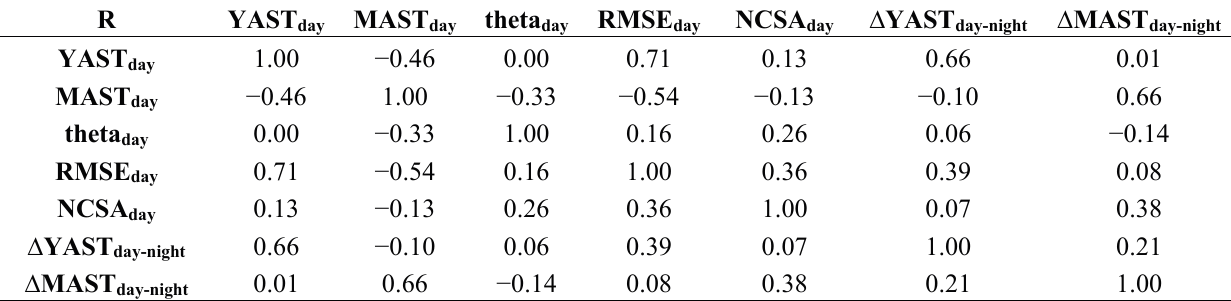
Table 2. Correlation between YAST, MAST, θ , NCSA respective day-night